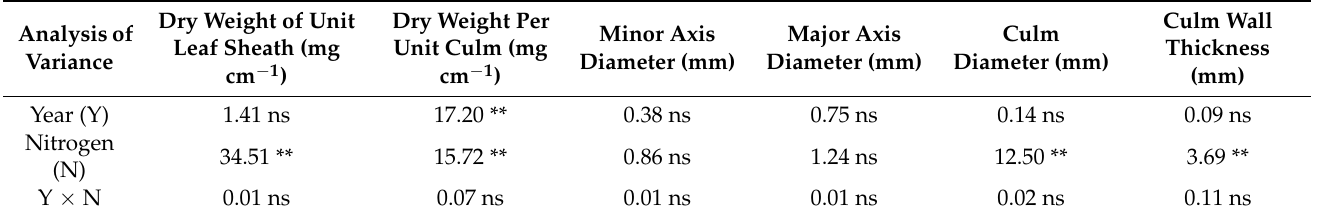
Table 6. Analysis of variance of morphological characteristics of the S2 basal internode.